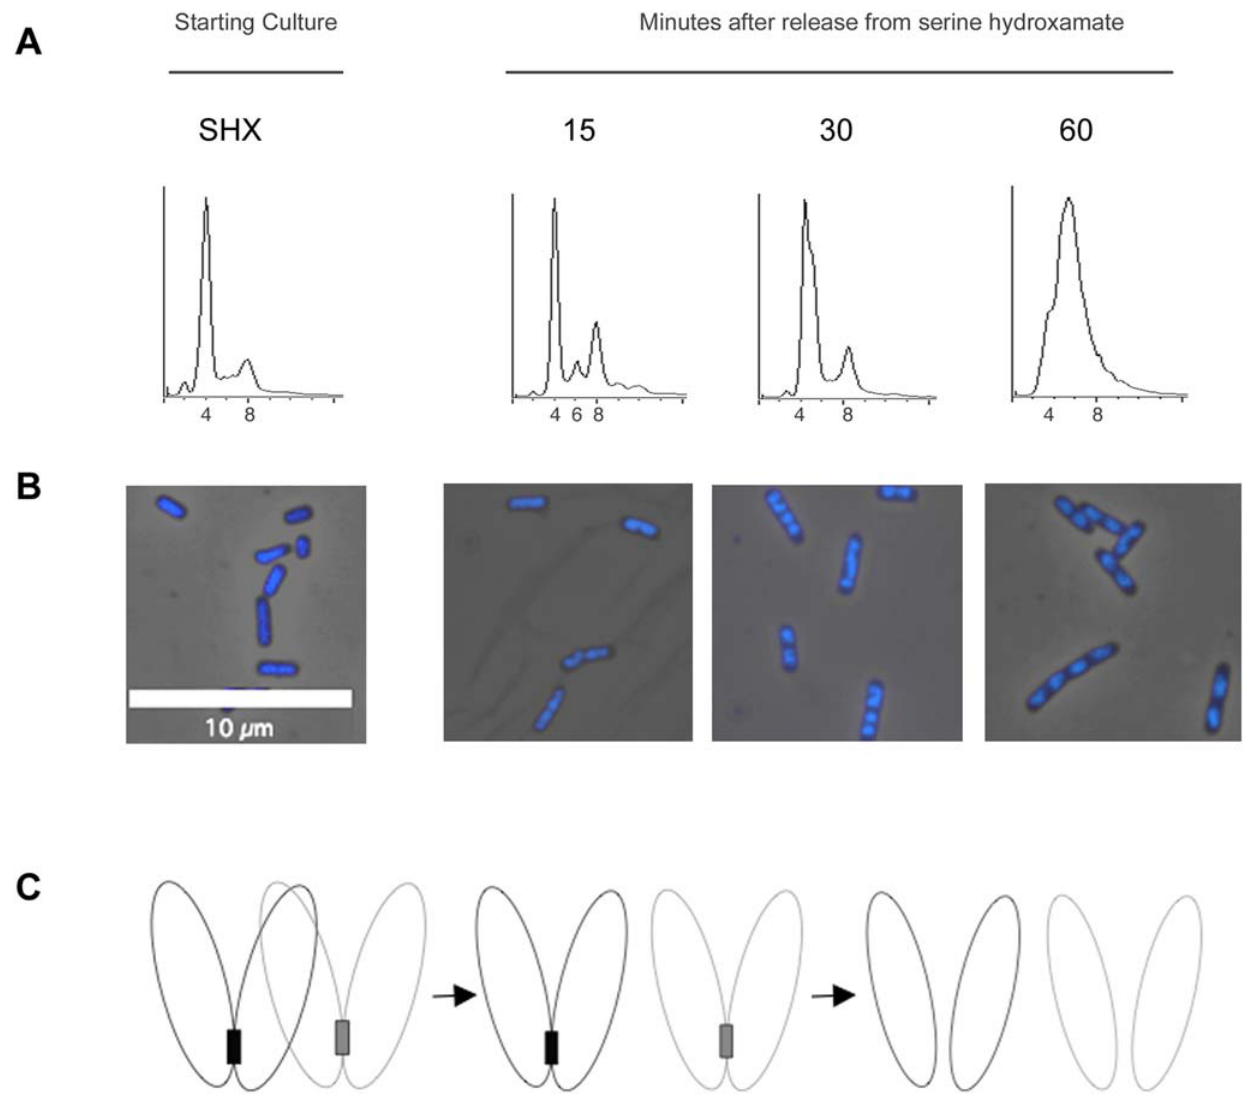
Figure 5. Release from stringent arrest. Wild type cells in M9 Glucose CAA medium were treated with serine hydroxamate for 1.5 h as previously described. Cells were then washed of serine hydroxamate, incubated in fresh medium, and samples were taken for flow cytometric analysis for DNA content and DAPI staining as previously described. (A) DNA content histograms and (B) corresponding fluorescent DAPI images of cultures incubated with serine hydroxamate for 1.5 h and of cultures at 15, 30, and 60 min after being released from serine hydroxamate. (C) Model for chromosome segregation patterns for 4N cells released from stringent arrest. Cohesion of sister chromosomes help enforce the sequence of segregation of chromosomes from the single nucleoid mass. Pairs of sister chromosomes held in cohesion at their termini segregate first at midcell. After release of cohesion, sisters separate at J positions.